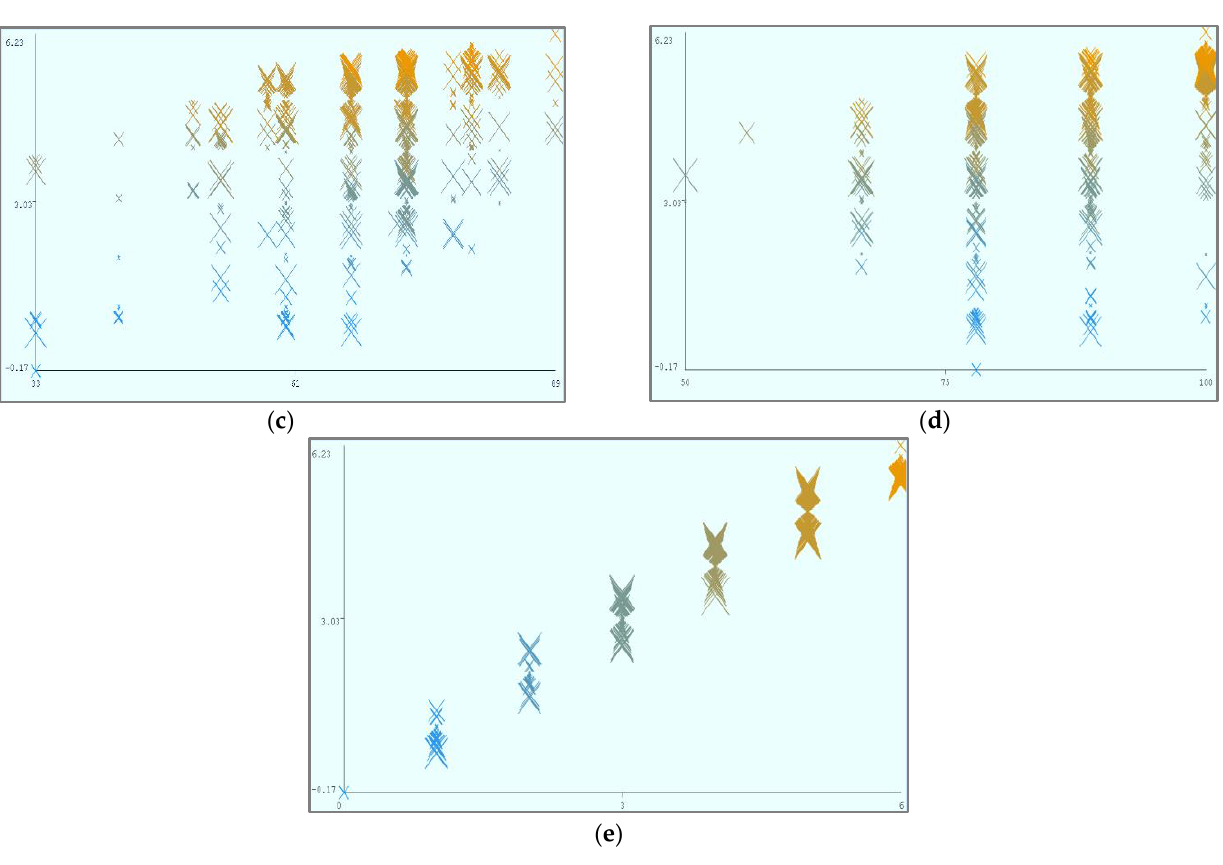
Table 6. Comparison of the Configuration